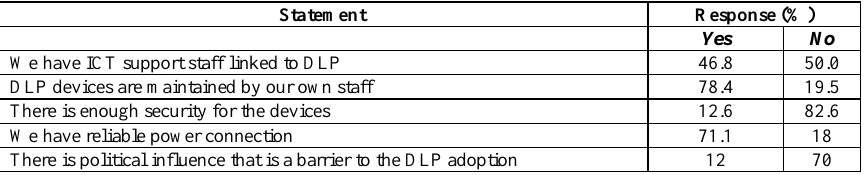
Table 5. Head teachers responses on environmental